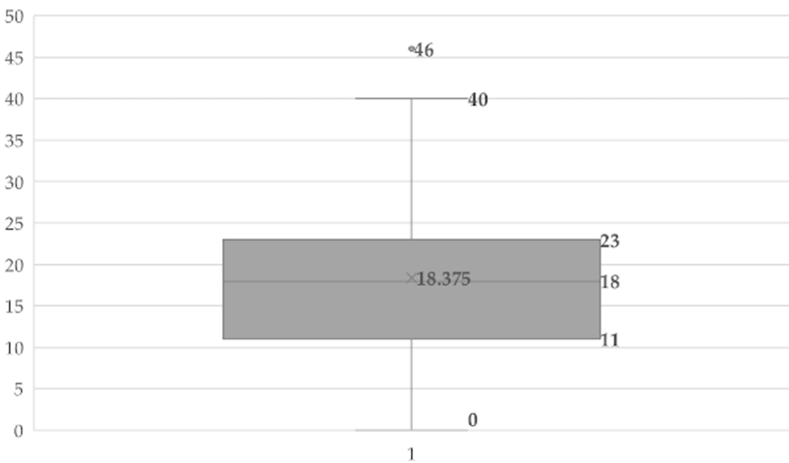
Figure 7. Distribution of progress points between the students’ diagnostic and final grammar tests participating in the course implemented with the Flipped Classroom model.